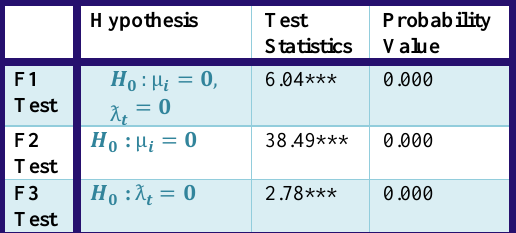
Table 6: F Tests for Companies Traded in Turkey Hypothesis Test Statistics